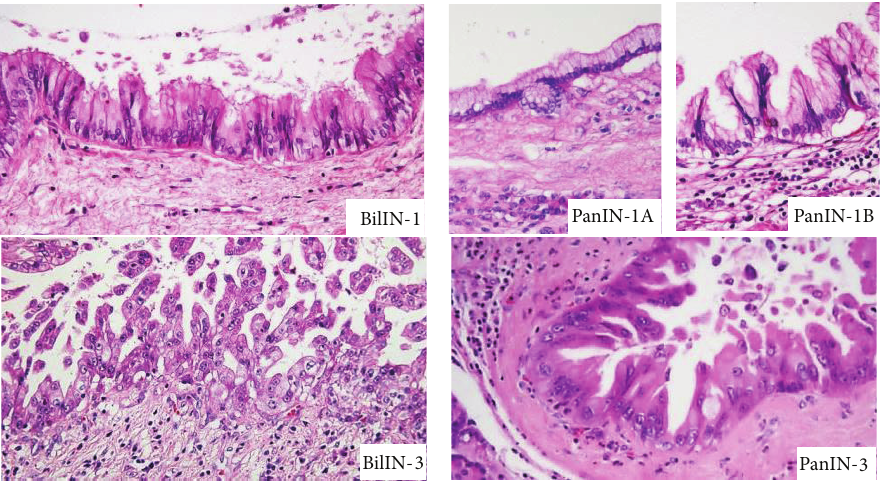
Figure 1: Histology of biliary intraepithelial neoplasia (BilIN) and pancreatic intraepithelial neoplasia (PanIN). Representative images of BilIN-1 and BilIN-3 and PanIN-1A, PanIN-1B, and PanIN-3 are shown. Hematoxylin and eosin staining. Original magnifications, ×